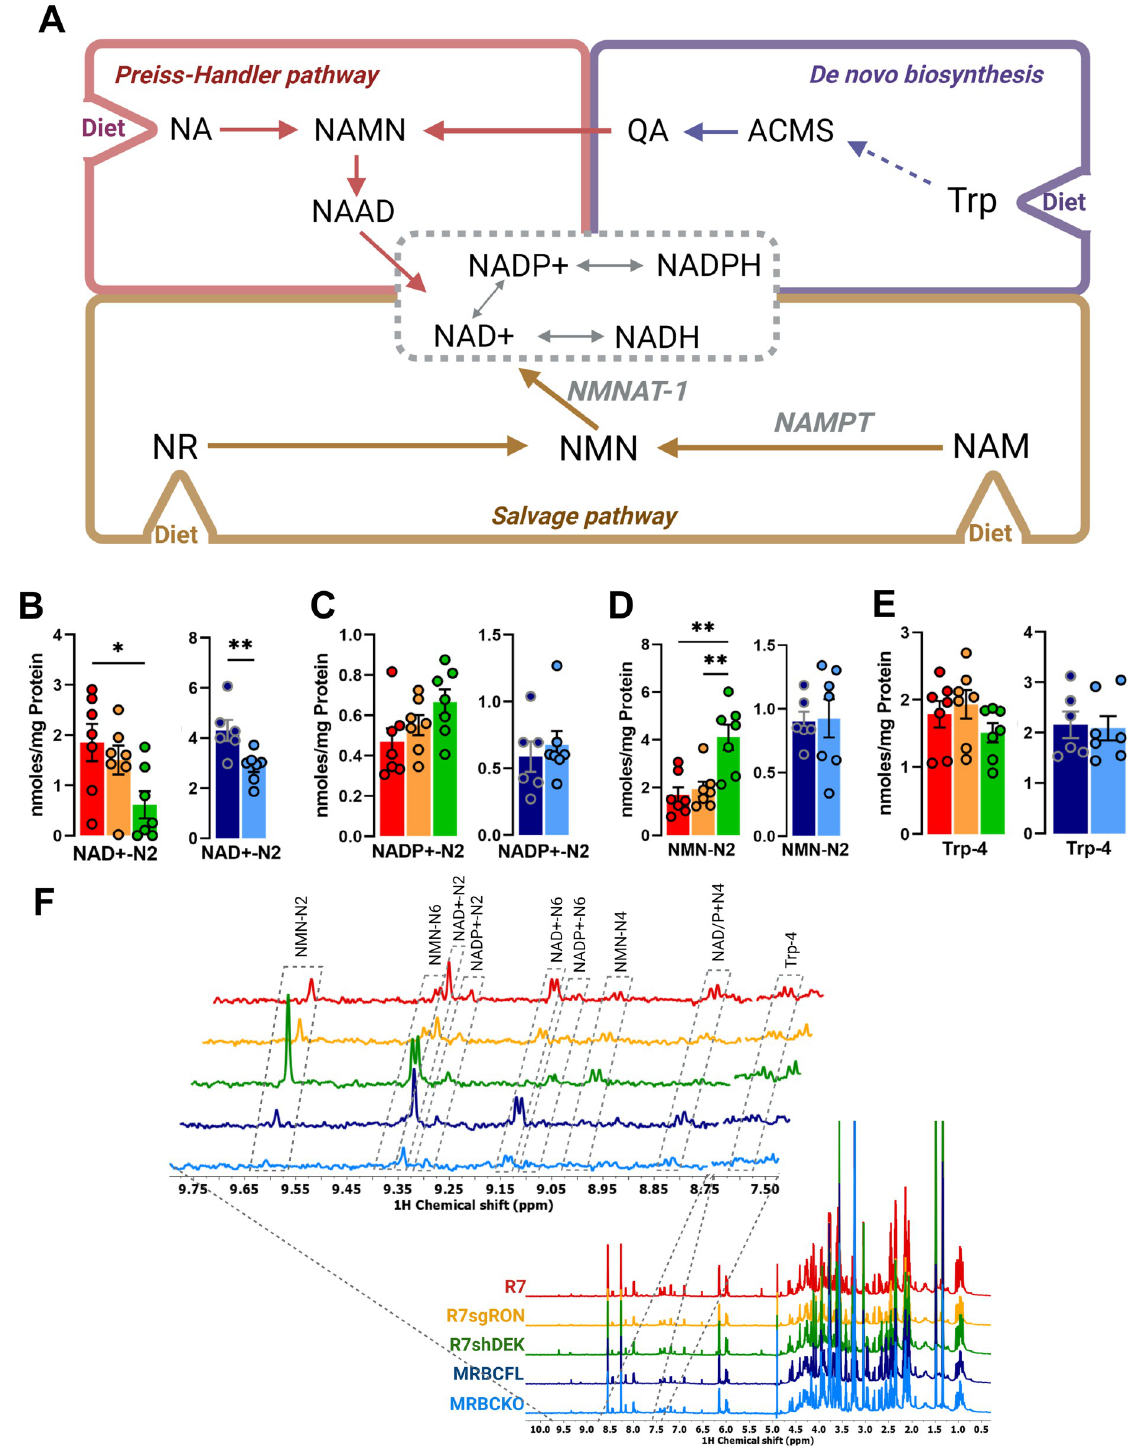
Fig 3. NAD + production pathway modulation by the RON-DEK- β -catenin axis. ( A ) Schematic of NAD + production pathways including de novo synthesis and salvage pathways (created with BioRender.com) illustrating the trends of R7 (red), R7sgRON (orange), R7shDEK (green), MRBC FL (dark blue), and MRBC KO cell lines (light blue). ( B ) Intracellular NAD + levels. ( C ) Intracellular NADP + levels necessary for de novo synthesis of NAD+. ( D ) Intracellular nicotinamide mononucleotide (NMN) levels. ( E ) Intracellular tryptophan (Trp) levels ( F ) Comparison of representative 1D 1H-NOESY spectra of the polar extract from R7, R7sgRON, R7shDEK, MRBC FL, MRBC KO cell lines.